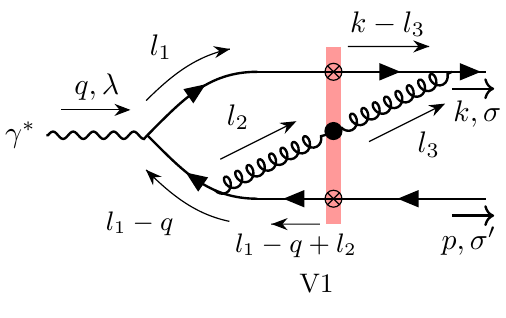
Figure 9 . Vertex correction from the gluon crossing the shock